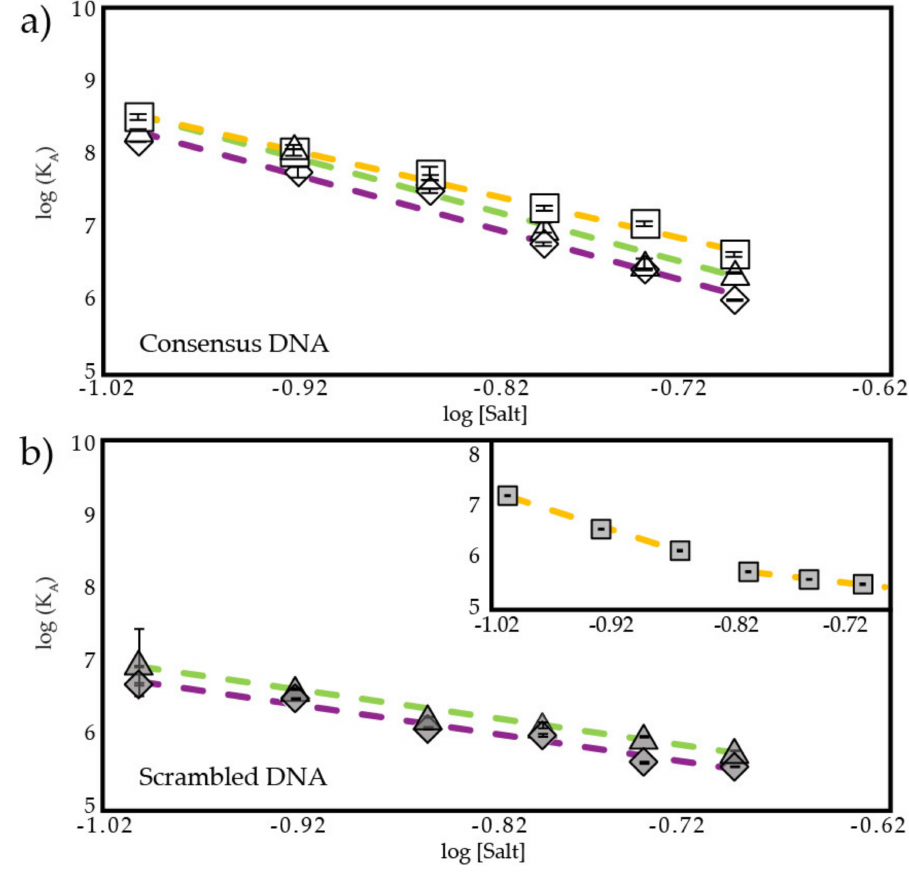
Figure 6. Salt-dependent binding affinity of ND mutants. Plot of log (K A ) vs. log[Salt] from 125–225 mM IS of ( a ) ND mutants binding consensus DNA, where is ND DE, is ND NP, is ND QS ( b ) ND mutants binding scrambled DNA, where is ND DE, is ND QS. Inset shows ND NP binding scrambled DNA, . R 2 values for all fit lines are between 0.96 and 0.99. Table 2. Slope of log (K A ) versus log [Salt] predicts ion release. Slope, N , with Consensus